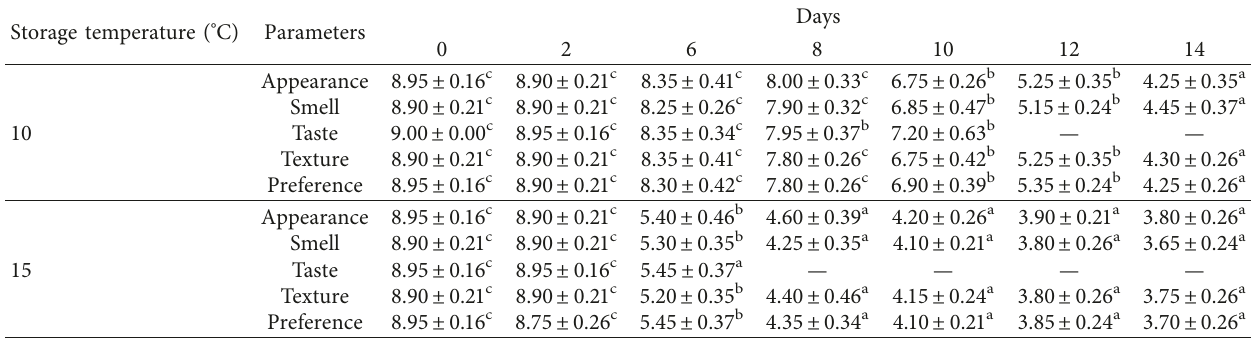
Table 8: Sensory evaluation of the processed squid stored at different